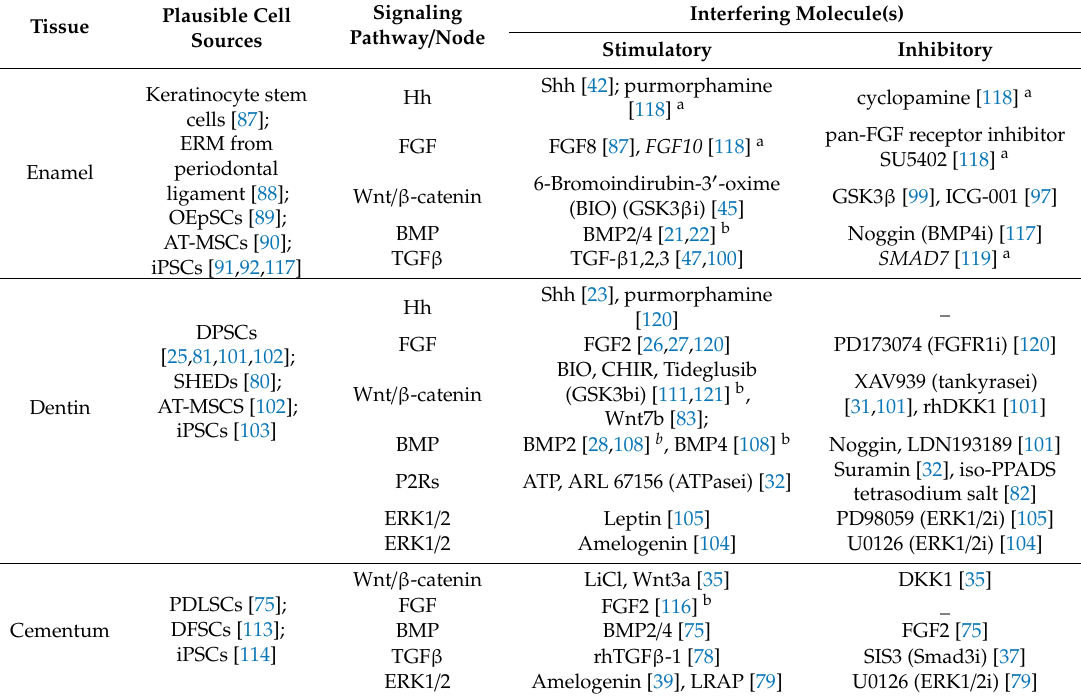
Cell Sources and signaling modulators useful for amelogenesis, dentinogenesis, and